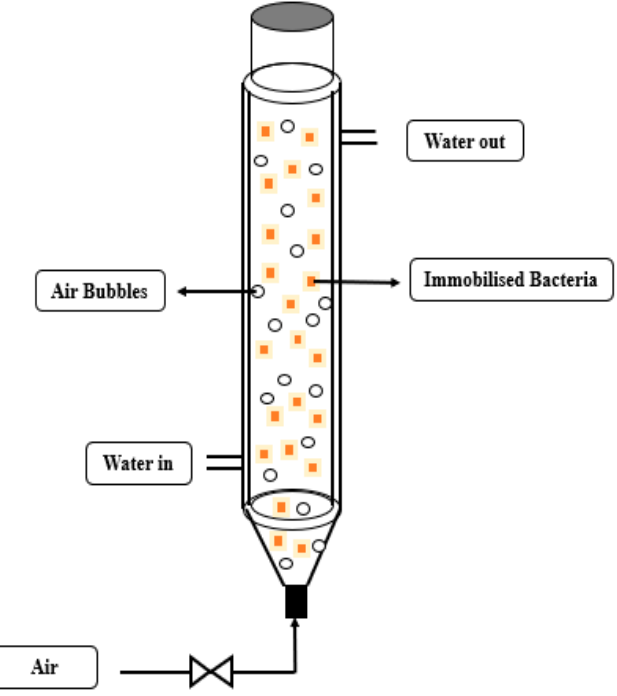
Figure 1. A schematic diagram of the spouted bed bioreactor